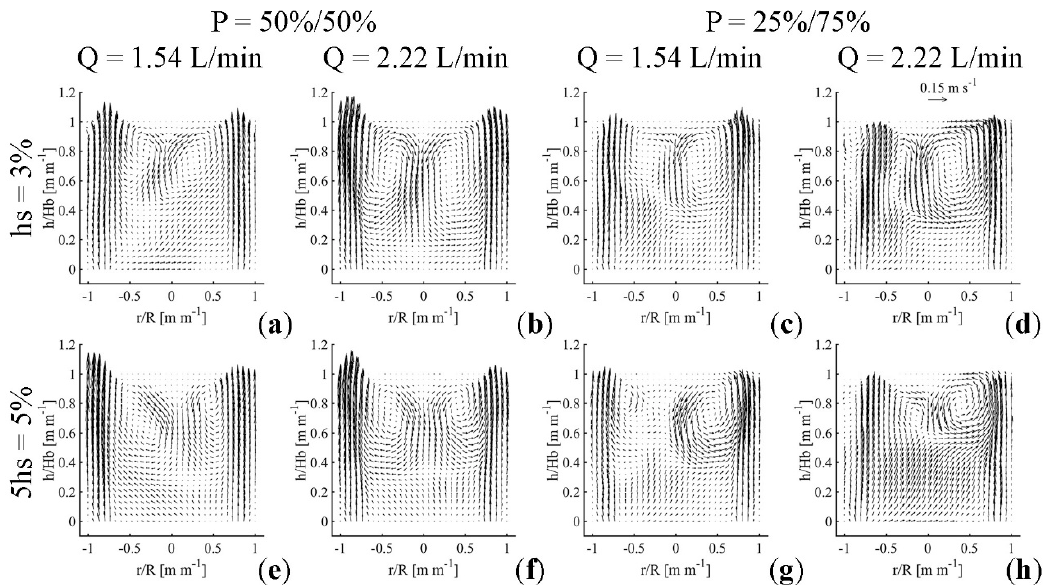
Figure 2. Flow patterns of the eight case studies obtained with the experimental model (particle image velocimetry (PIV) technique) in the longitudinal plane. ( a ) through ( h ) are the experiments described in Table 2.